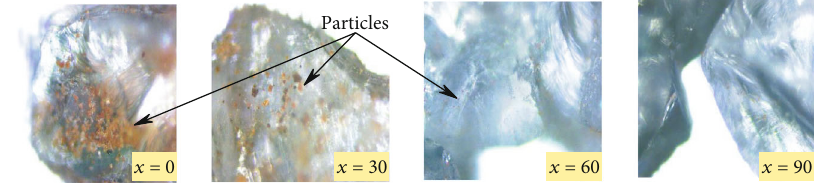
Figure 7: Microscope images at di ff erent column cross-sections x (unit: